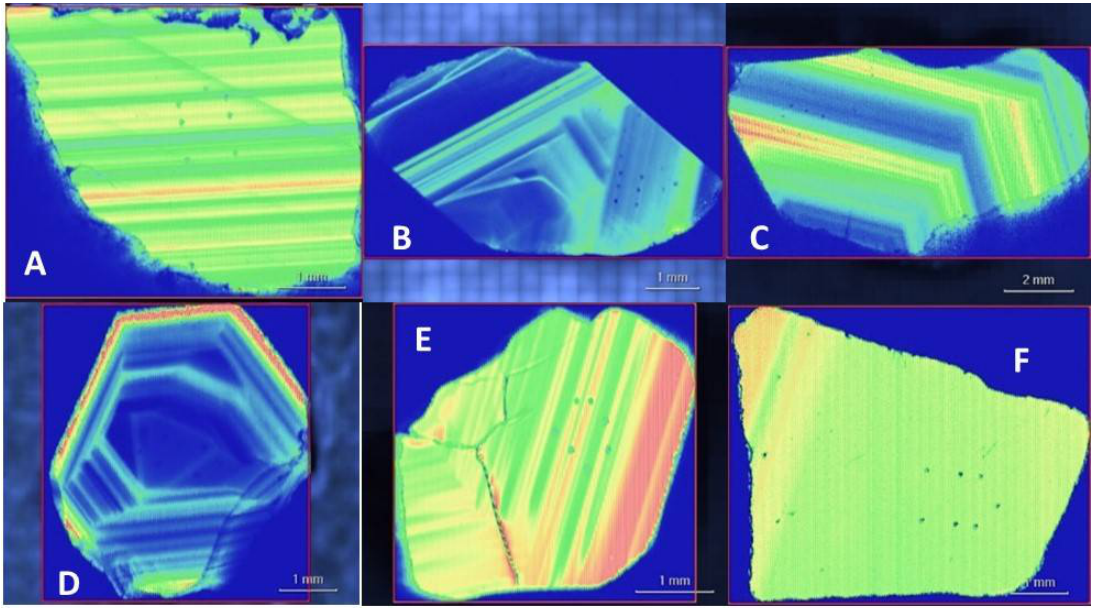
Figure 18. Representative PL maps showing Cr distribution in Madagascar sapphires demarcating ( A – E ) sharp, oscillatory growth patterns, often arranged in hexagonal patterns, as well as ( F ) diffuse variations in Cr concentrations.